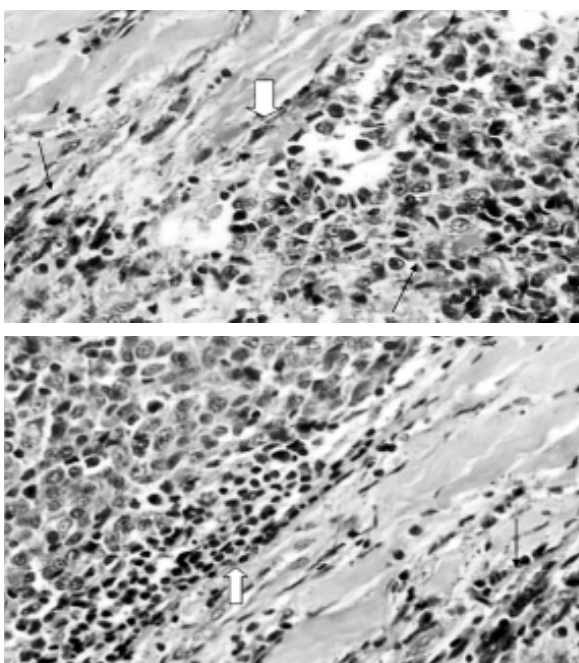
Fig. 7 - Aspecto microscópico do tumor invadindo fibras musculares cardíacas. Notar o aspecto infiltrativo do tumor, a invasão e destruição das fibras miocárdicas pela neoplasia (setas brancas largas) e a presença de grande quantidade de melanina (setas